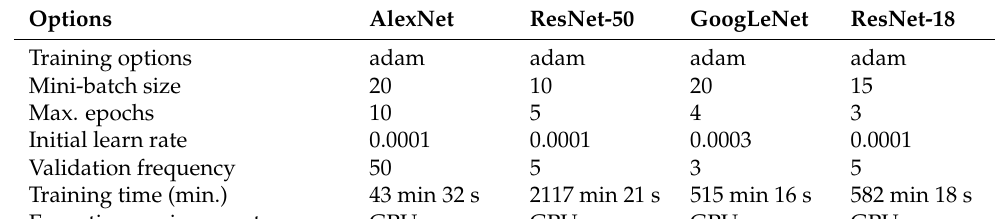
Table 3. Training parameter options for the CNN models.